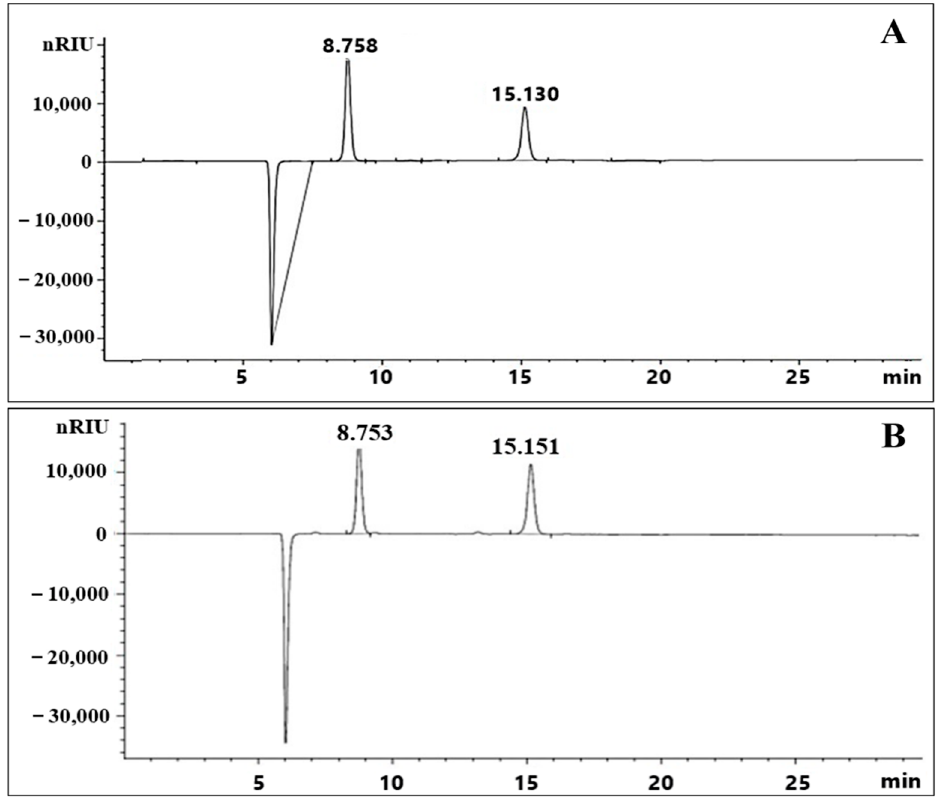
Figure 2. HPLC chromatogram of hydrolysate of dextran from ( A ) Standard and ( B ) Dextran from Apilactobacillus waqarii